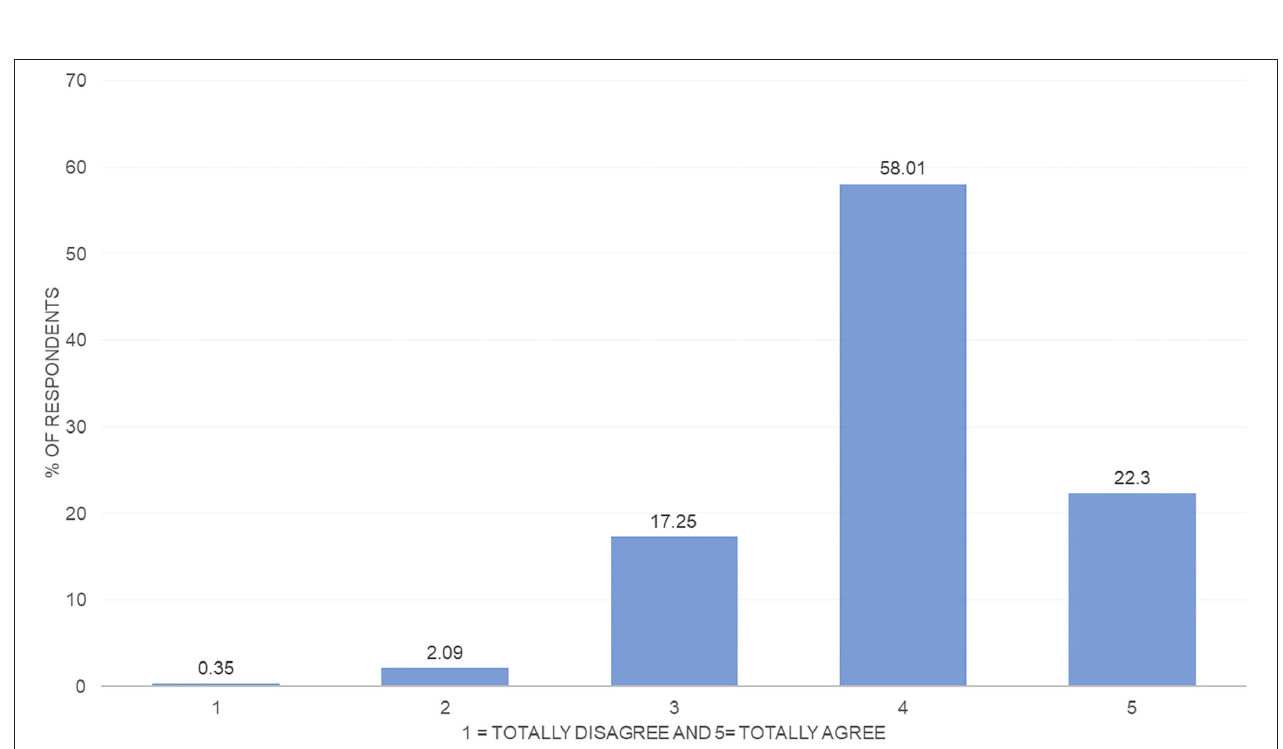
FIGURE 3 | Declared behavior regarding food waste—distribution. Source: Own elaboration.